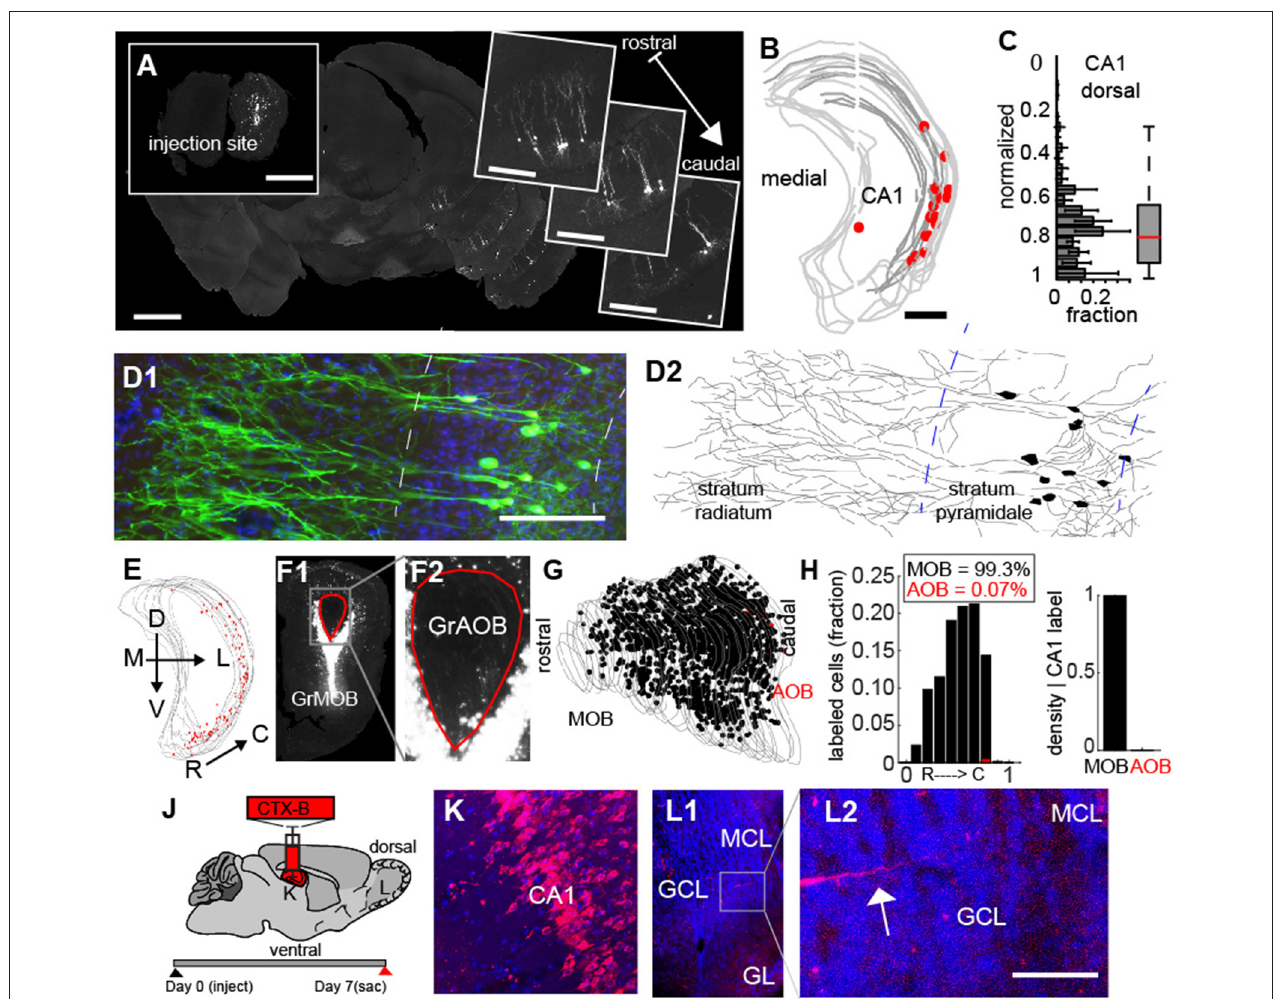
FIGURE 6 | Monosynatic feedback projections from CA1 hippocampus to the main olfactory bulb. (A) Widefield fluorescent image of an example of feedback projecting neurons from CA 1 to granule cells in the olfactory bulb (insert). Scale bar = 500 um. (B) 3D-reconstruction of hippocampus/CA 1 boundaries with retrogradely labeled neurons (red). Scale bar = 500 um (C) Normalized dorsal-ventral distribution of retrogradely labeled neurons in CA 1. (D1) Confocal image of CA 1 neurons. (D2) Reconstruction of neuronal morphology from cells in D1 . Scale bar = 200 µ m. (E) Example of densly labeled neurons in vCA 1. Gray lines = CA 1 boundary. Red dots = retrograde labeled neurons. (F1) Injection site in the bulb corresponding to CA 1 reconstruction in (E) . GrMOB = Granule cells in main olfactory bulb (MOB). Red line corresponds to the accessory olfactory bulb (AOB) boundary. (E2) Enlargement of AOB from E1 . GrAOB = Granule cells of AOB. (G) Reconstruction of all sections of the MOB injection from (E1) . Black dots = labeled neurons in MOB. Red dots = labeled neurons in AOB. Gray lines = granule cell layer boundary. (H) Distribution of labeled cells along the rostral-caudal axis (normalized) for MOB (black) and AOB (red) in left and ratio of MOB to AOB cells for densly labeled injection sites (right). CTX-B = cholera toxin B subunit. (K,L) Correspond to subsequent panels. (J) Schematic for anterograde label of axons projecting to the MOB from vCA 1. (K) CTX-B injection into CA 1. (L1) MOB with axonal arbors from CA 1 injection. (L2) Enlargement of G2 shows feedback processes from CA 1. Scale bar = 50 µ